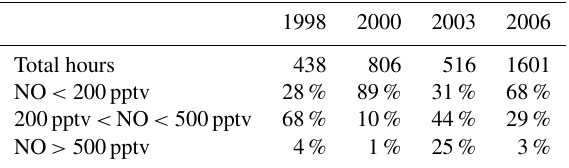
Table 1. Percentage of hourly NO values in three ranges compared over the four experiment years shown in Fig.